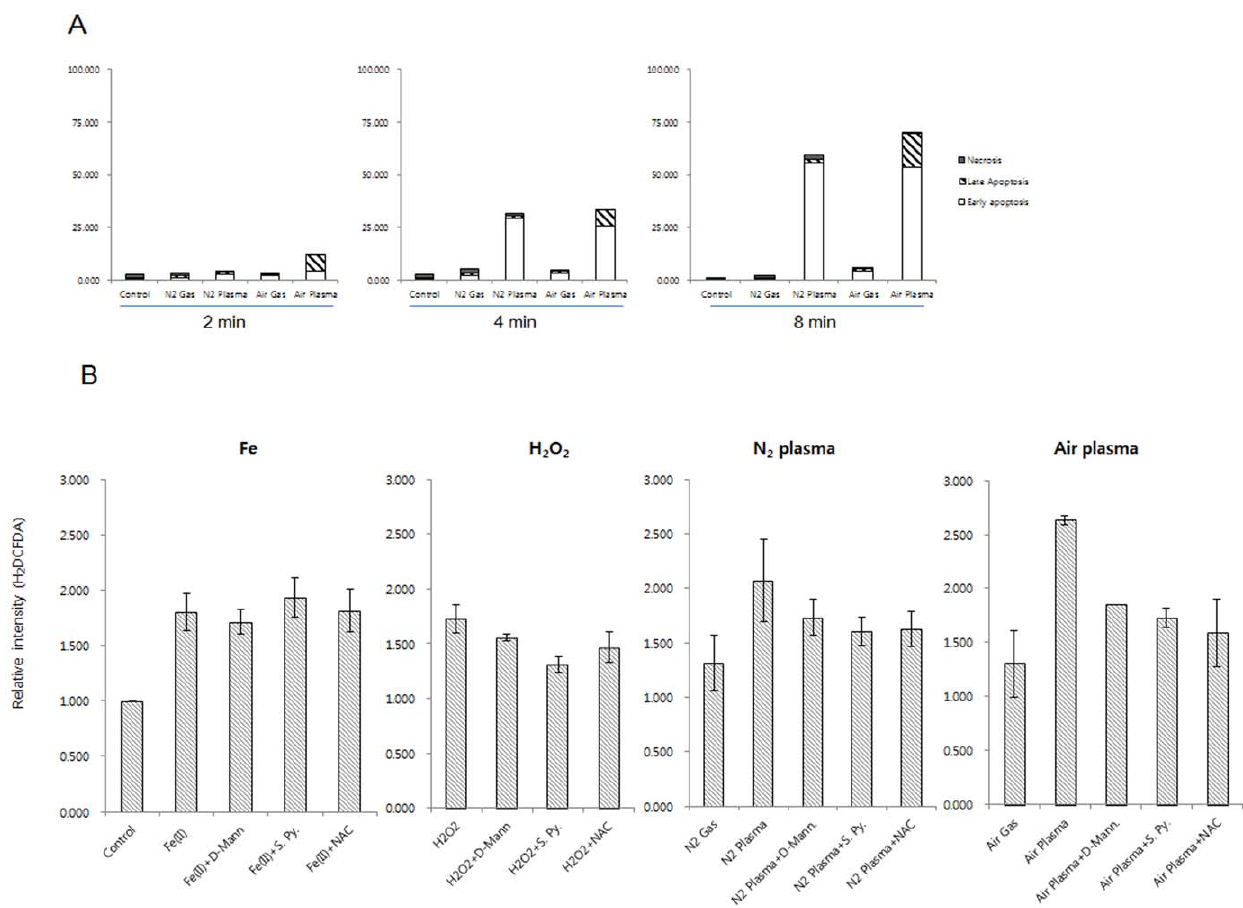
Figure 3. Plasma induces apoptosis via generation of ROS. (A) Apoptosis in HeLa cells, a human cervical carcinoma cell line, was analysed by flow cytometry, following staining with anti-Annexin V-FITC and PI. HeLa cells were treated with a N 2 or air plasma jet for 2–8 min as indicated, and incubated further for 24 hr. Cells in early apoptosis are stained with Annexin V antibody only, while cells at the late apoptotic stage are stained with both annexin V antibody and PI. Necrotic cells were stained with only PI. Data are shown as the mean 6 s.e.m. ( n =8). (B) ROS generation was monitored by flow cytometry. Cells were incubated with 2.5 m M H 2 DCFDA, harvested, and within 1 hr of treating cells with a N 2 or air plasma jet for 5 min, the level of ROS was evaluated by measuring the emission of DFC. Non-treated (-), Ferrous (II) perchlorate- (Fe), and H 2 O 2 - treated cells (H 2 O 2 ) were employed as controls. As antioxidants, D-mannitol (D-Mann), sodium pyruvate (S Py.), or N-Acetyl-Cysteine (NAC) was used. Data are shown as the mean 6 s.e.m. ( n